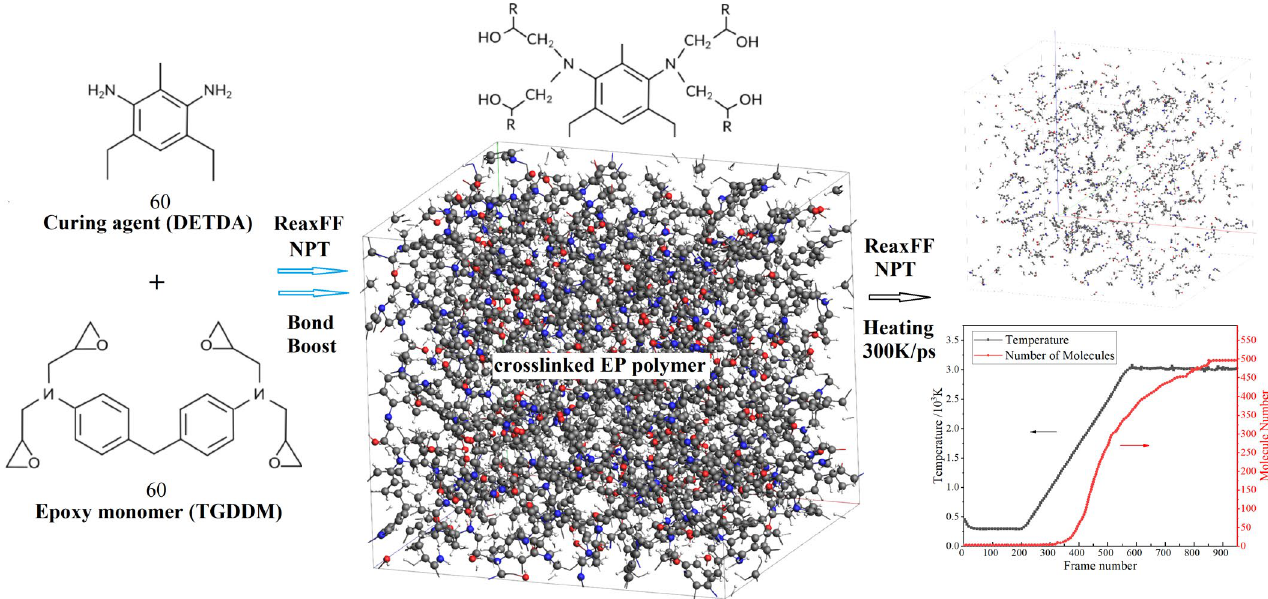
Figure 1. Schematic process of modeling crosslinked EP polymers, in which the gray, blue, red, and white spheres denote carbon, nitrogen, oxygen, and hydrogen atoms, respectively.